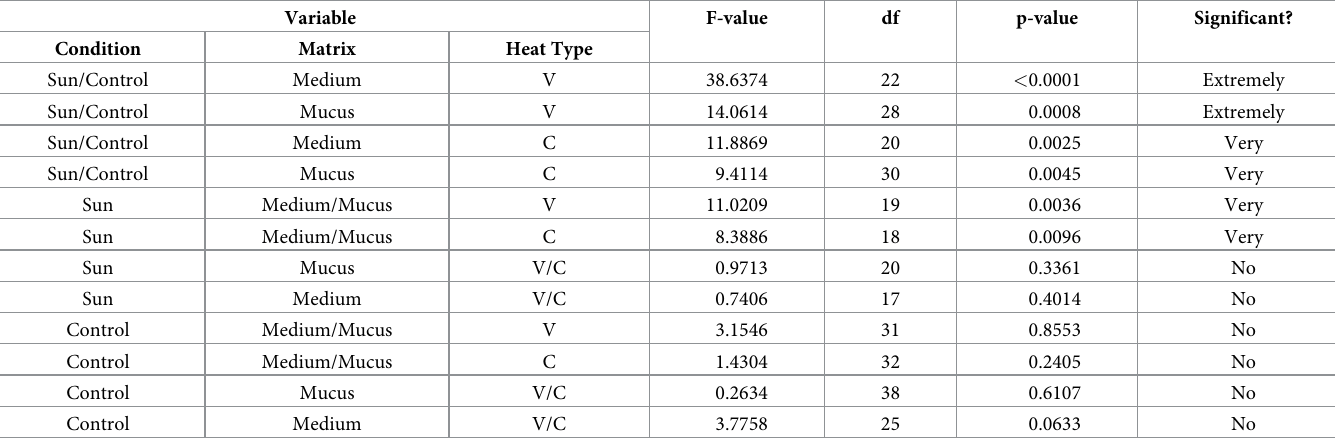
Table 1. Results of linear regression analyses between data